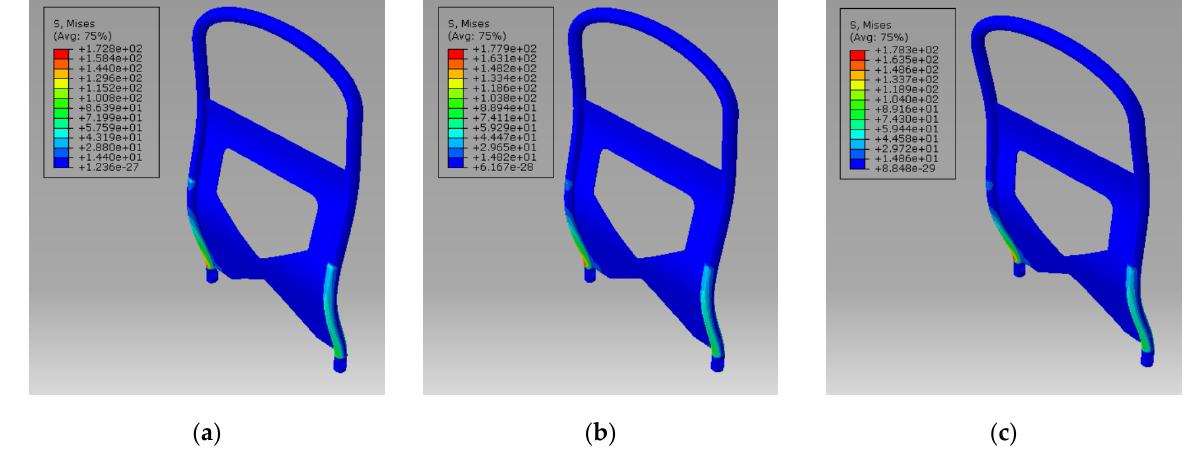
Figure 6. Stress contour of car seat frames: ( a ) Q235A; ( b ) AL 6061-T6; ( c ) 40% LECT/PP. Table 3. Comparison between car seat frames made of different materials.